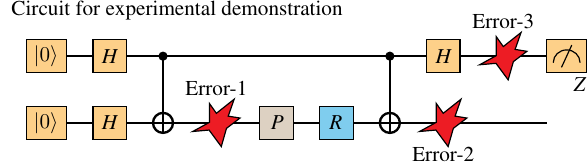
FIG. 9. Two-qubit DQCp circuit used in the experimental demonstration of the learning-based quantum error mitigation protocol.